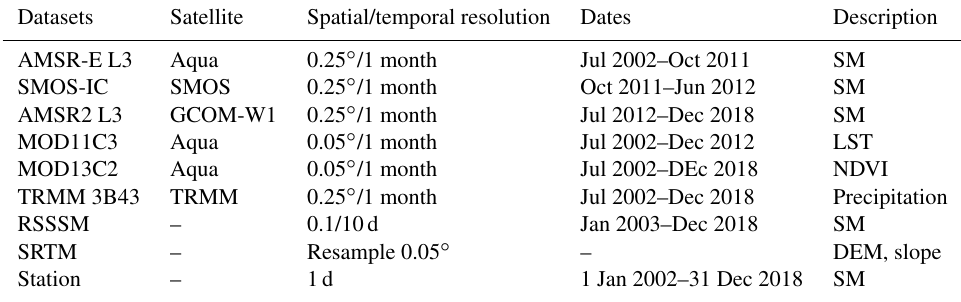
Table 1. Overview of the datasets used in this